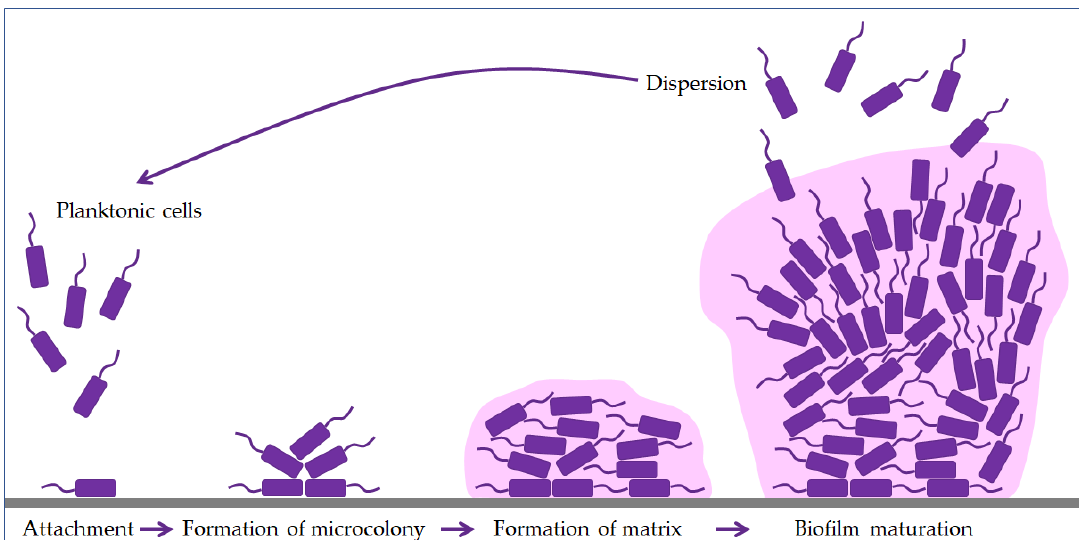
Figure 1. Phases of biofilm formation. The formation starts with the attachment of planktonic cells (purple), followed by binding to the surface (grey). The bacteria then form a microcolony and begin to produce an extracellular matrix (pink). In the maturation phase, the biofilm grows into a tower or mushroom-shaped structure due to the polysaccharides. Finally, some bacteria start to disperse to another site and form a new biofilm.